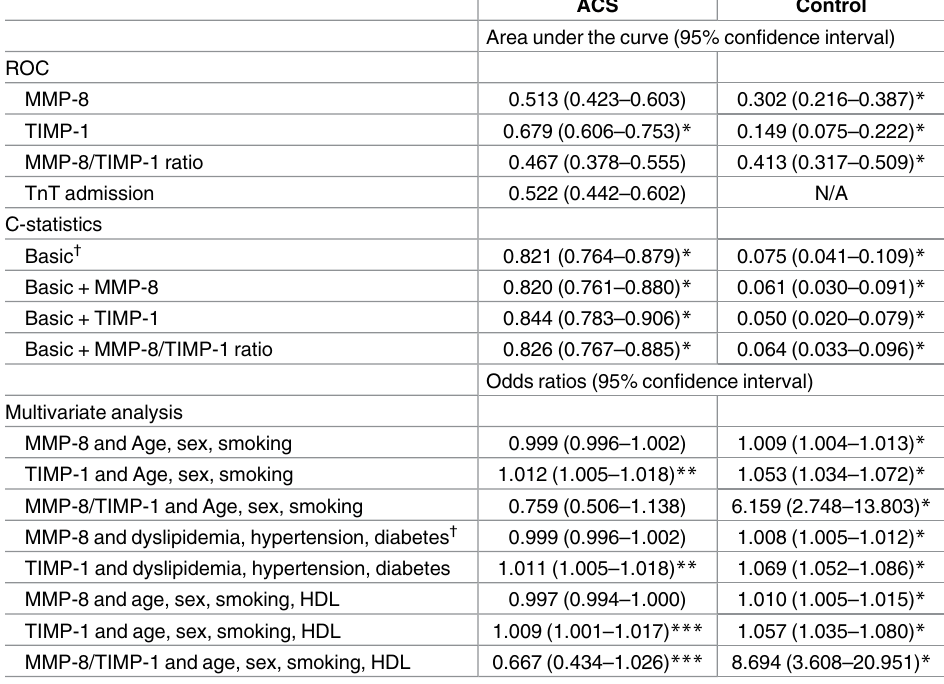
Table 2. Receiveroperating characteristics, c-statistics and multivariate analysis in ACS and control compared to